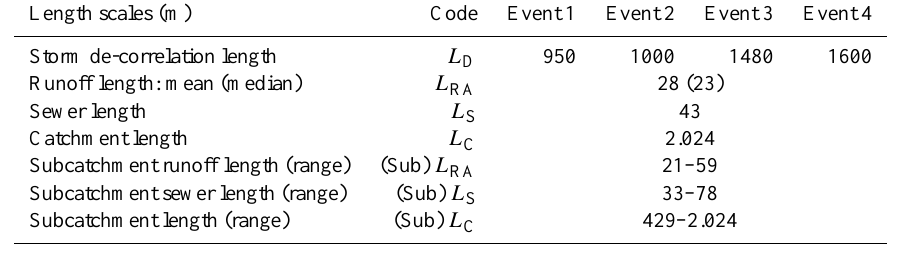
Table 3. Scale lengths related to catchment, runoff areas and sewer density, for the total catchment as well as length scale ranges for the 10 subcatchments.